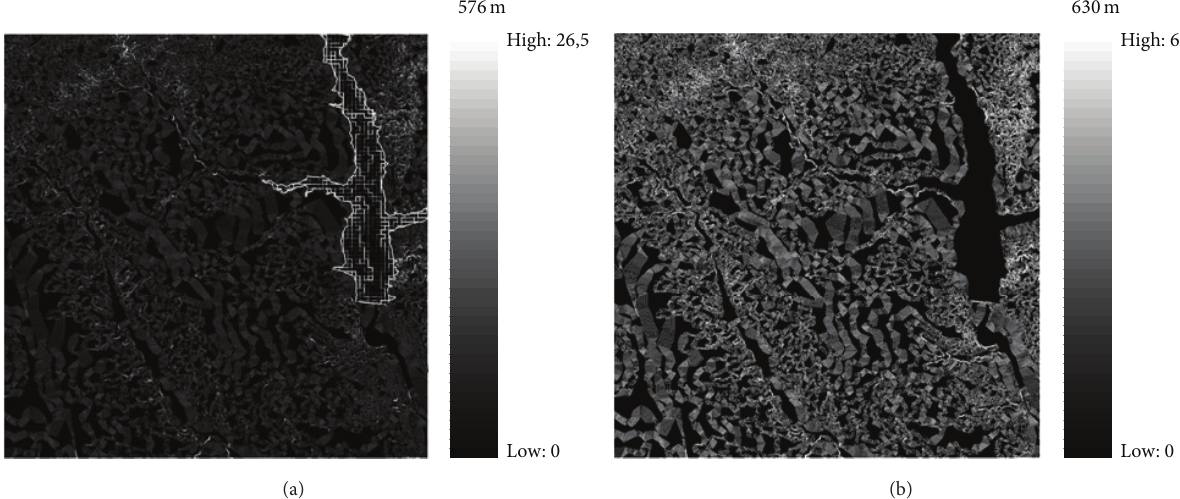
Figure 5: Absolute gradient, |Δ𝑚 𝛿 (𝑥,𝑦)| ≈ |𝑚(𝑥,𝑦) − (𝑚(𝑥 + 𝛿, 𝑦) + 𝑚(𝑥,𝑦 + 𝛿) + 𝑚(𝑥 − 𝛿, 𝑦) + 𝑚(𝑥,𝑦 − 𝛿))/4| , where 𝑚 refers to the original altitude value at the point ( 𝑥,𝑦 ) in DEM and 𝛿 = 1 . (a) With the water reservoir empty (minimum altitude 576 m). (b) With the water reservoir full (minimum altitude 630